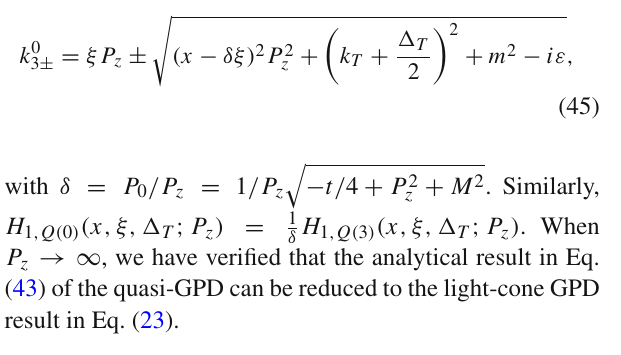
Fig. 5 Quasi-TMD h ⊥ different values of P z and TMD h ⊥ |(cid:2) k | . Upper left panel: h ⊥ T